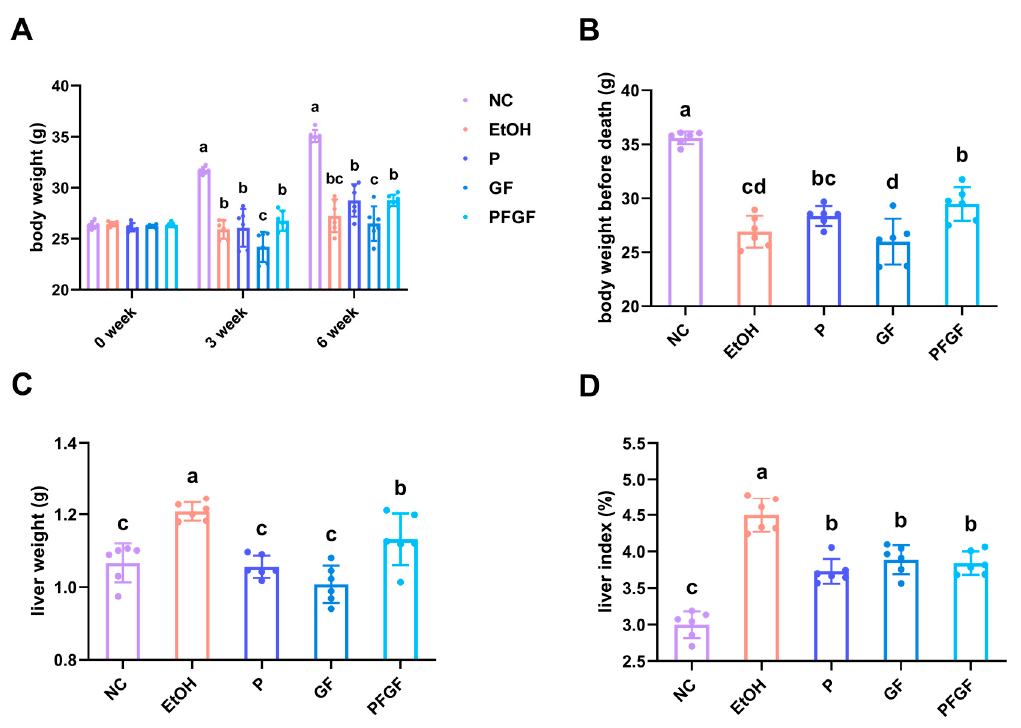
Figure 1. Effects of P, GF, and PFGF on body weight ( A ), body weight before death ( B ), liver weight ( C ), and liver index ( D ) in alcohol-fed mice. Data are expressed as mean ± SD ( n = 6). Different superscript letters indicate statistically significant differences between groups ( p < 0.05).